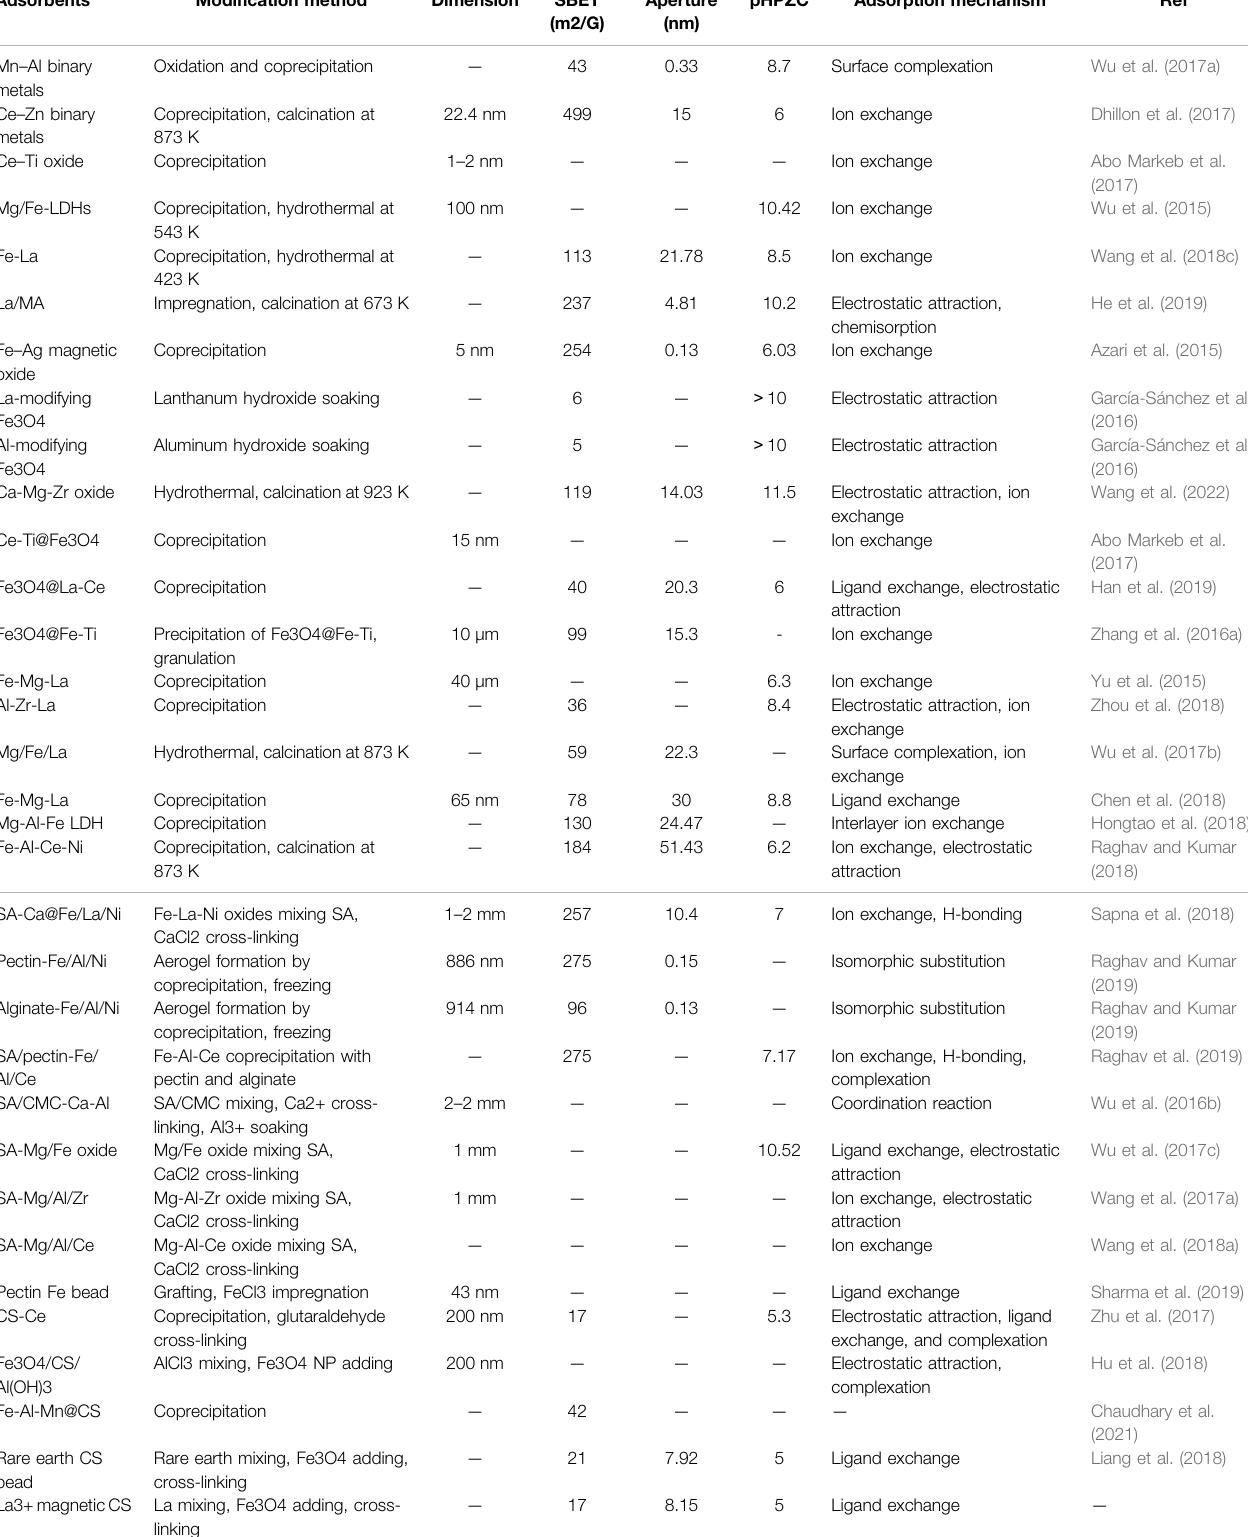
TABLE 4 | Summary of modi fi cation methods, characteristics, and adsorption mechanisms of muti-metal and metal-biopolymer composite